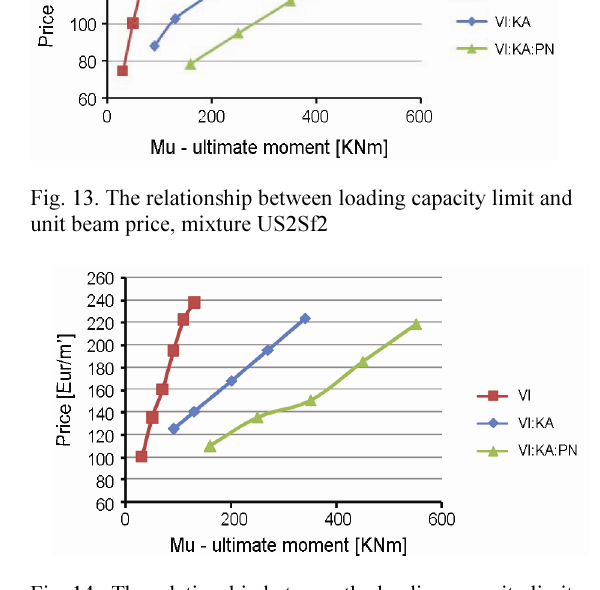
Fig. 14. The relationship between the loading capacity limit and the unit beam price, mixture